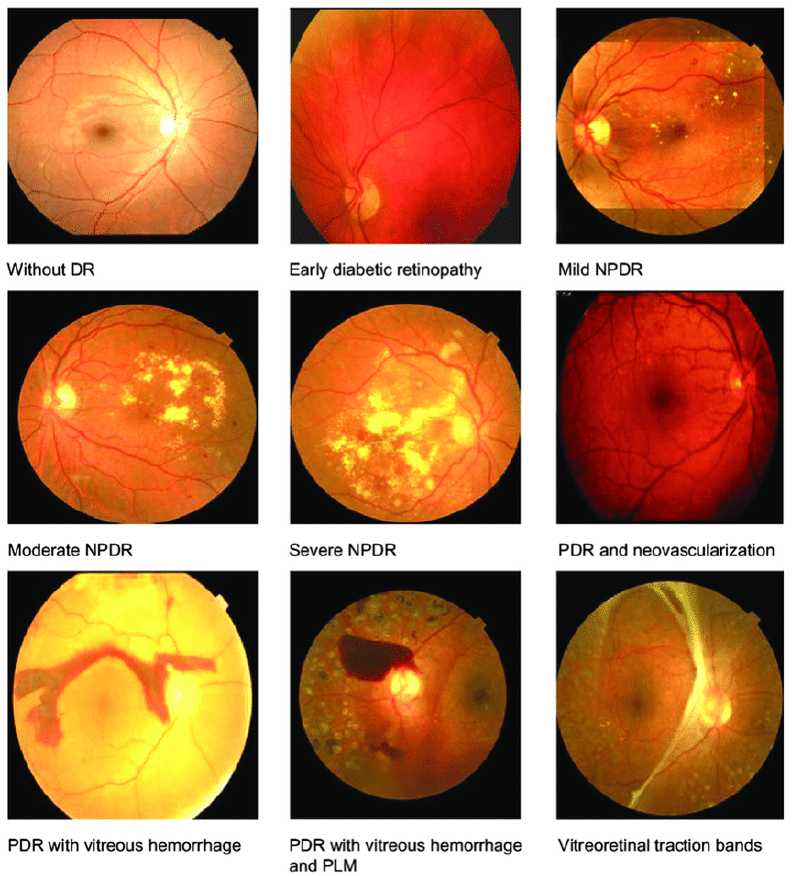
Figure 2. Stages of diabetic